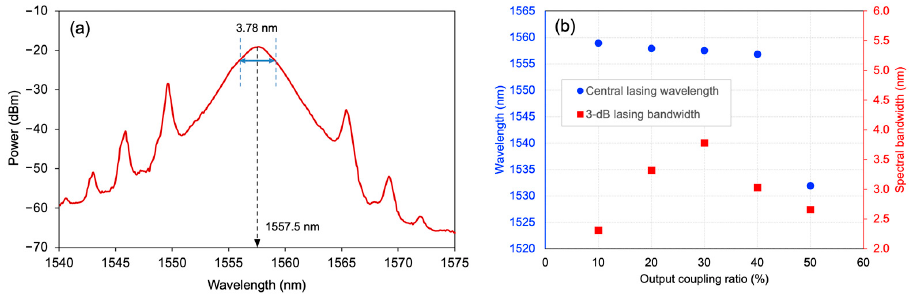
Figure 7. ( a ) Optical spectrum of EDFL generated by GNP-SA using a 30% output coupling ratio and ( b ) central wavelength and spectral bandwidth for different output coupling ratios.